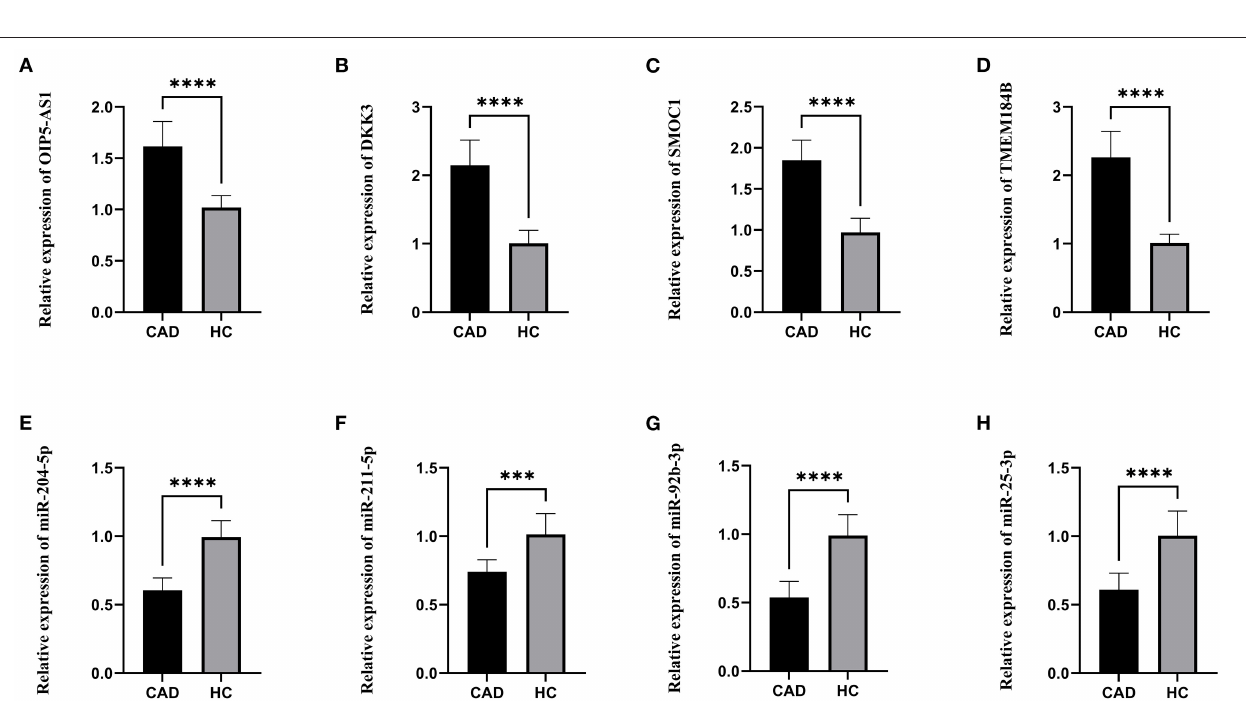
FIGURE 6 | The relative expression levels. (A) The relative expression level of OIP5-AS1. (B) The relative expression level of DKK3. (C) The relative expression level of SMOC1. (D) The relative expression level of TMEM184B. (E) The relative expression level of miR-204-5p. (F) The relative expression level of miR-211-5p. (G) The relative expression level of miR-92b-3p. (H) The relative expression level of miR-25-3p. CAD, Coronary artery disease; HC, Healthy control. *** p < 0.001, **** p < 0.0001.